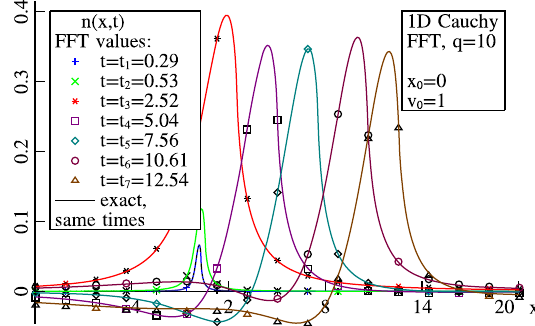
FIG. 3. The density n 1 ð ~ x ; t Þ for the infinite plasma with the 1D Cauchy velocity distribution obtained via exact formula (116) and numerically via the FFT.